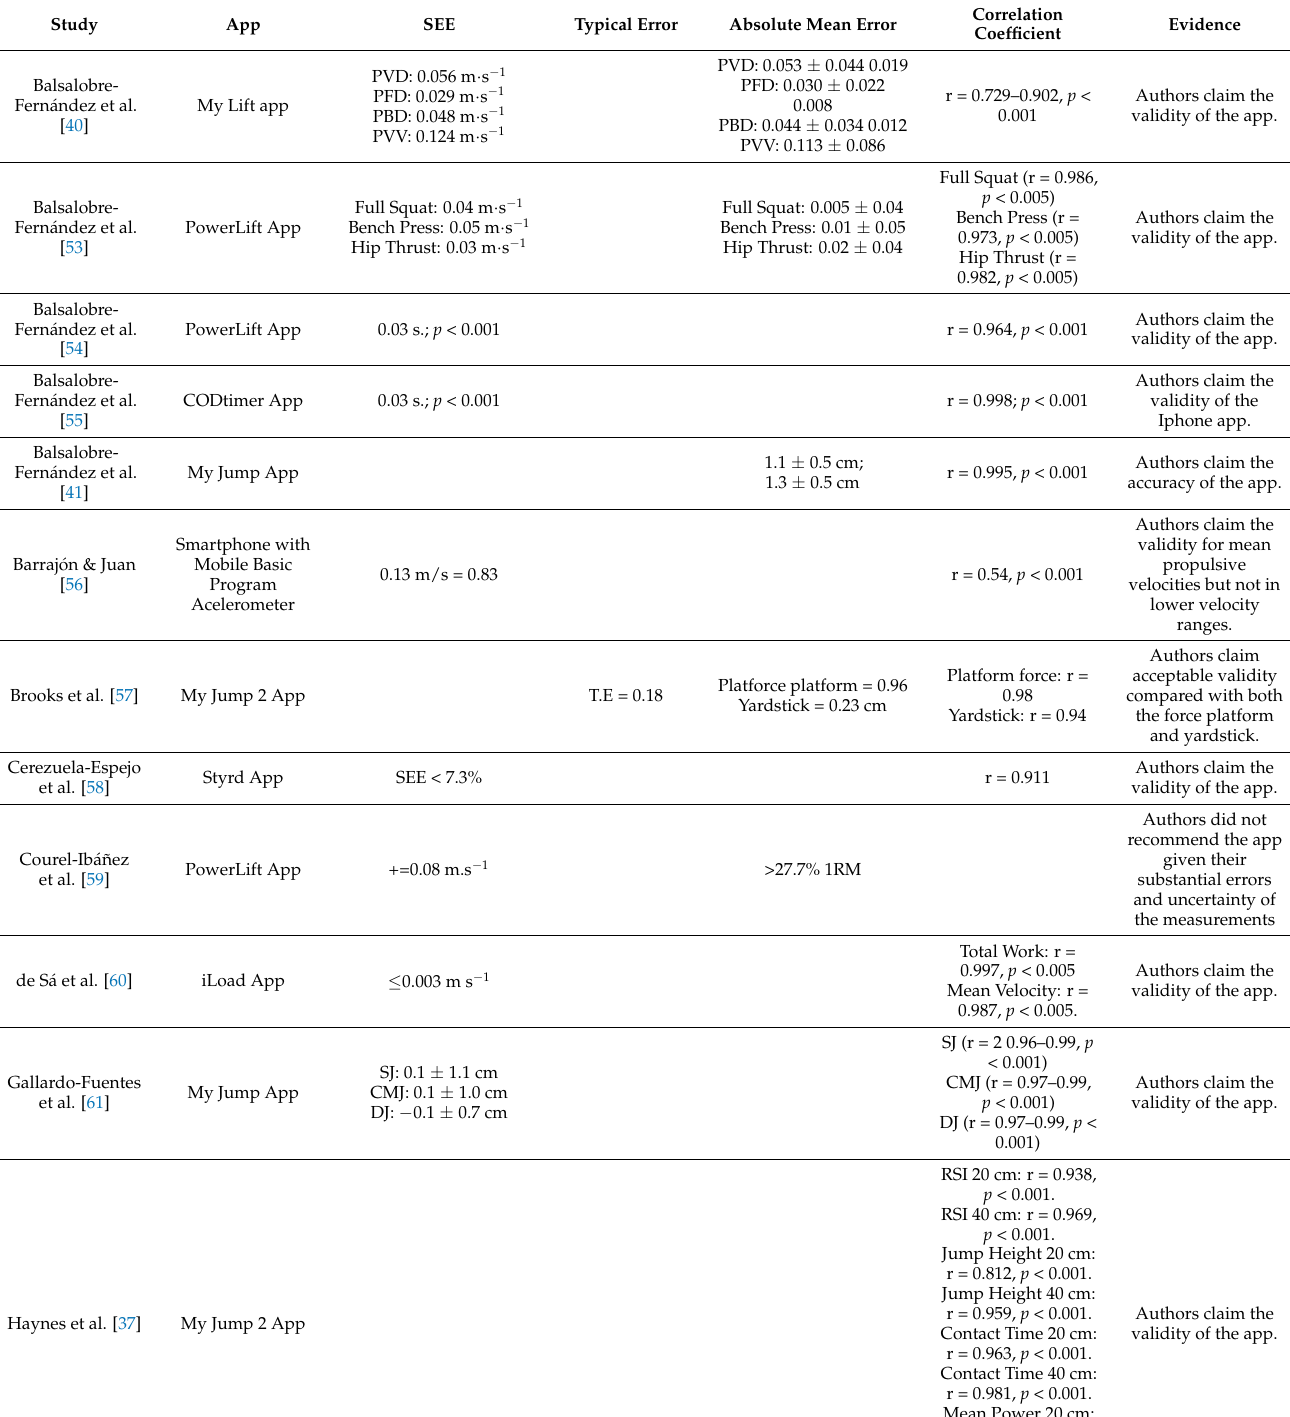
Table 4. Validity of apps for estimation of movement velocity, movement time and movement